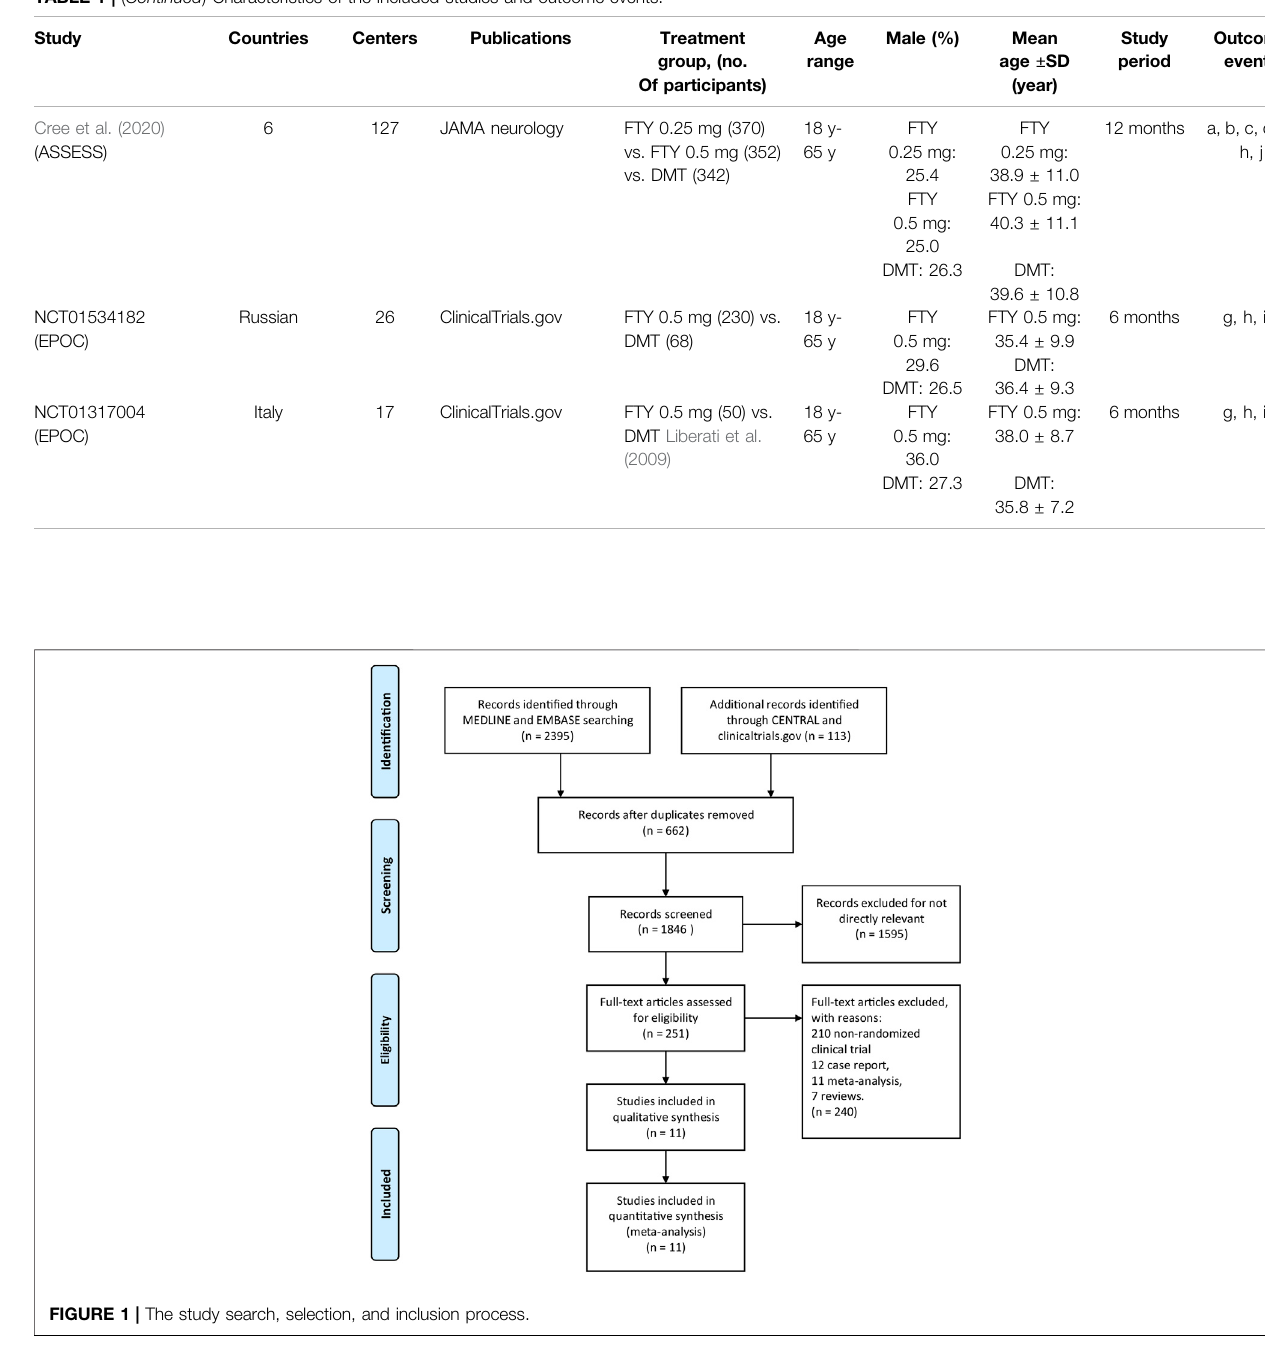
TABLE 1 | ( Continued ) Characteristics of the included studies and outcome